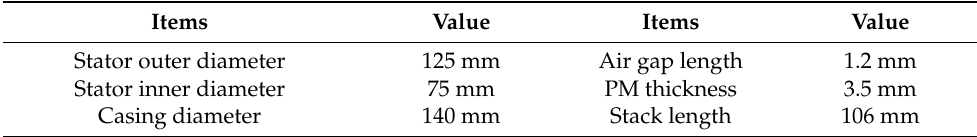
Table 1. Main structural parameters of the